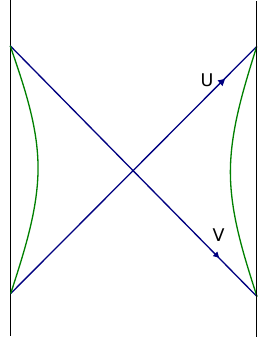
Figure 1 . Near-horizon AdS 2 geometry of the near-extremal black hole, showing the cutoff bound- aries and horizons. The coordinates U, V increase towards the right